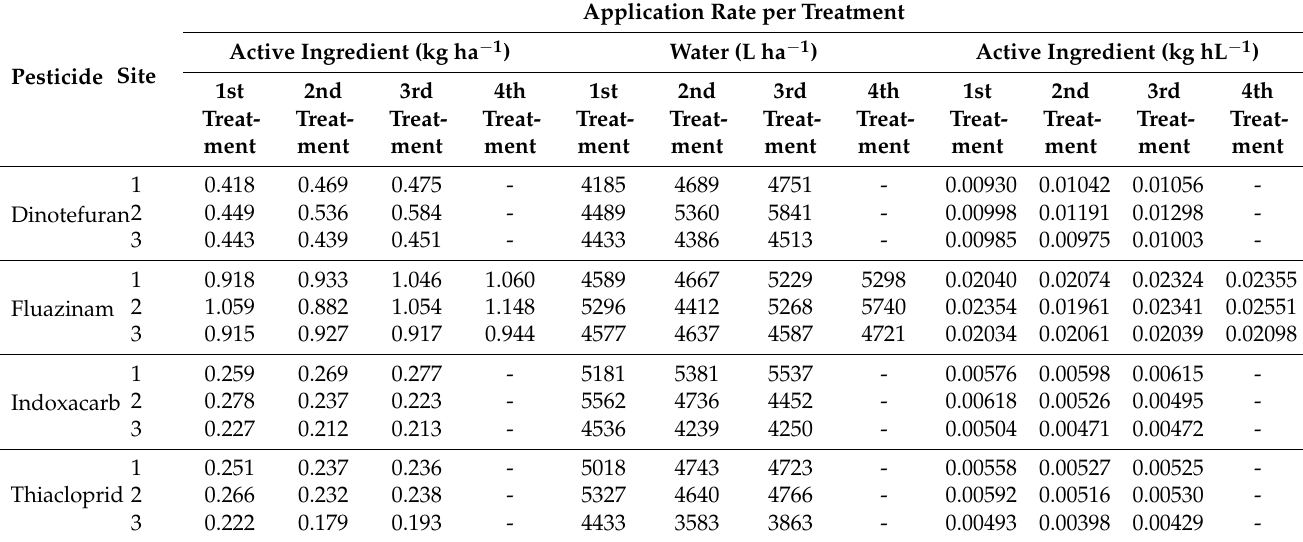
Table 1. Detailed information of pesticide sprayed onto